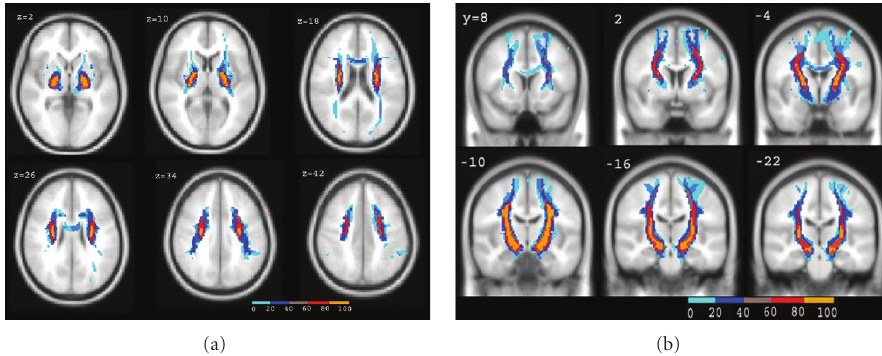
Figure 8: The corticospinal tract overlapped in axial sections (a) and coronal sections (b). The color bars indicate the relative frequency of voxels containing the corticospinal tract from 0 to 100% (yellow) at the 20% step.